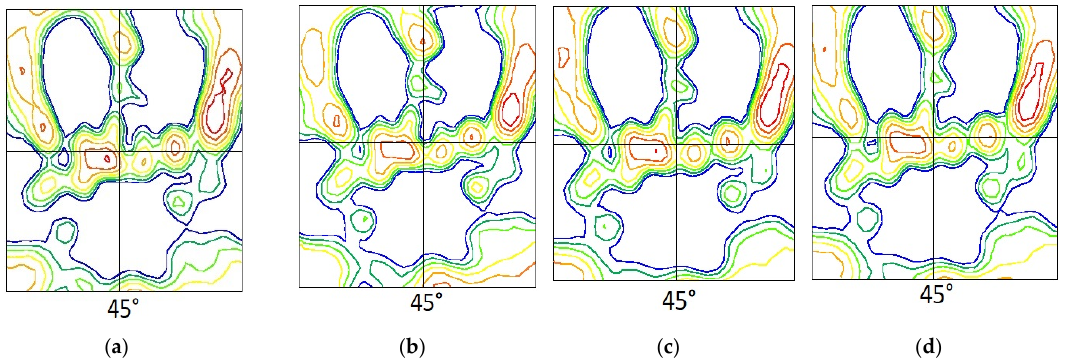
Figure 11. Typical ideal orientation observed after ECAP passes at high temperature. ( a ) No pass, ( b ) first pass, ( c ) second pass, ( d ) third pass.